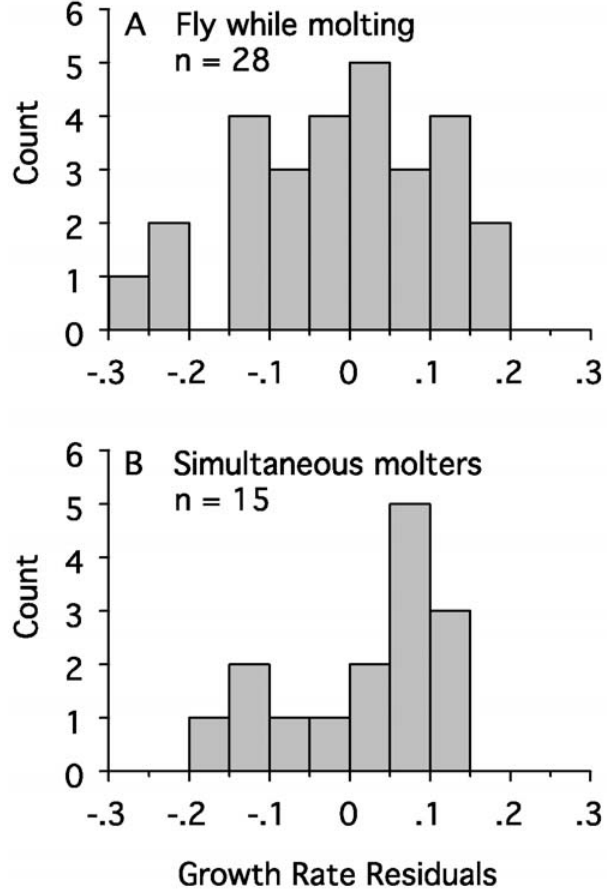
Figure 3. Deviations from the growth rate regression in Figure 1, plotted separately for species that fly while molting and for species that replace their wing quills simultaneously. The latter grow their primaries no slower than birds that fly while molting, suggesting that follicular constraints on the rate of feather synthesis, rather than energetic costs, limit the rate at which flight feathers grow.